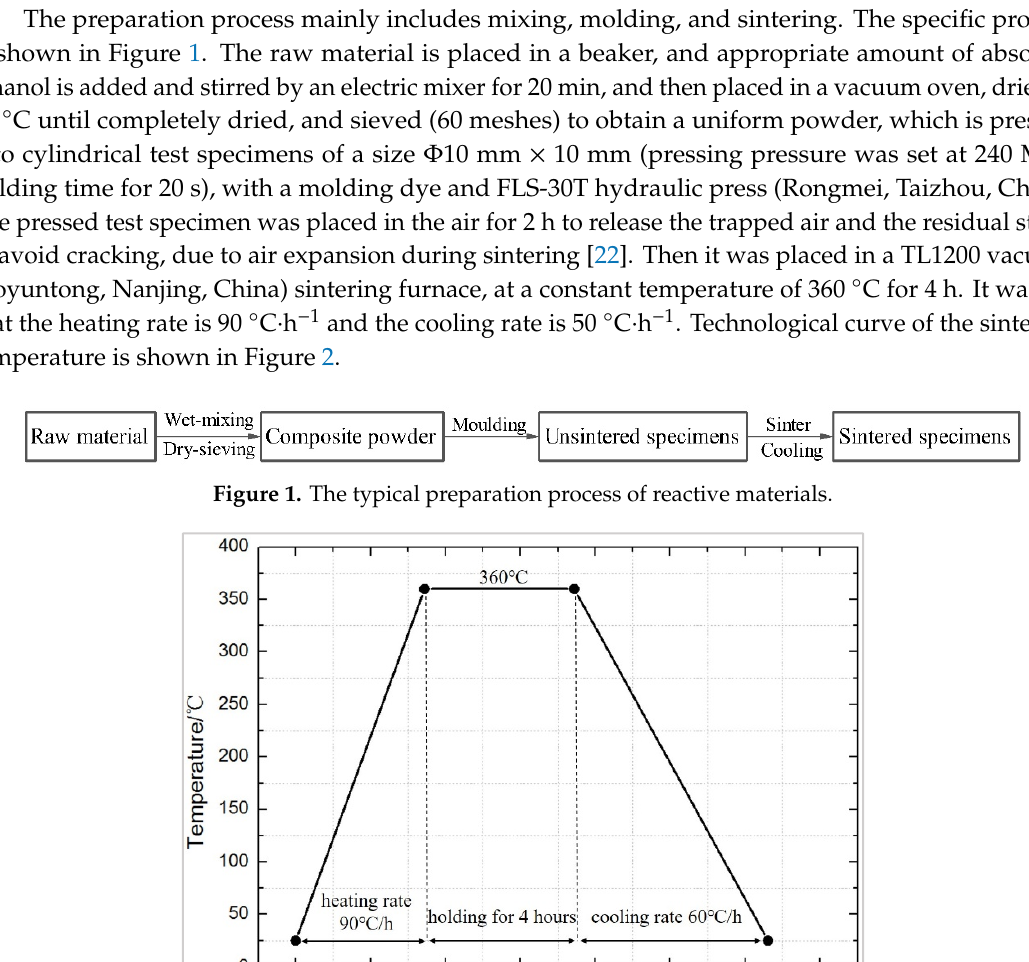
Figure 2. The typical sinter temperature curve of reactive materials.